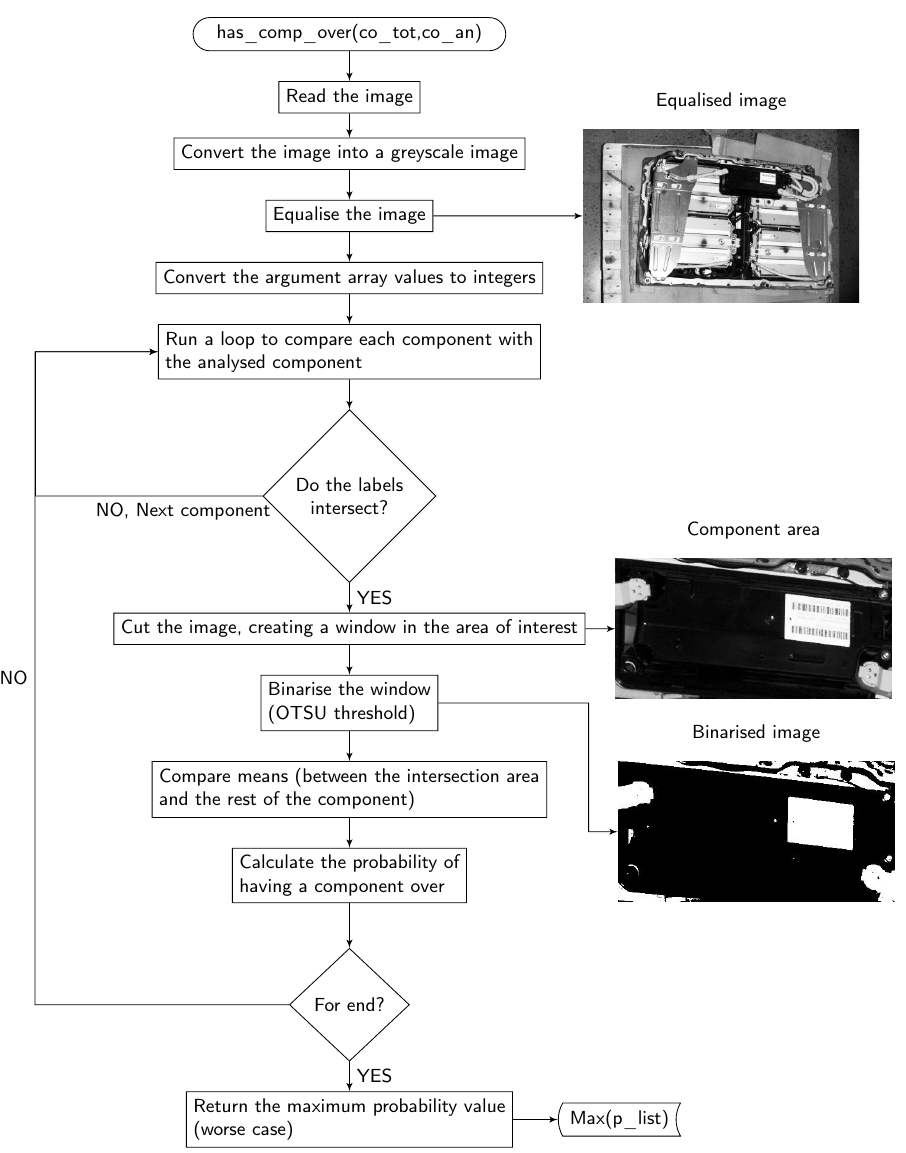
Figure 6. Function has_comp_over flow chart